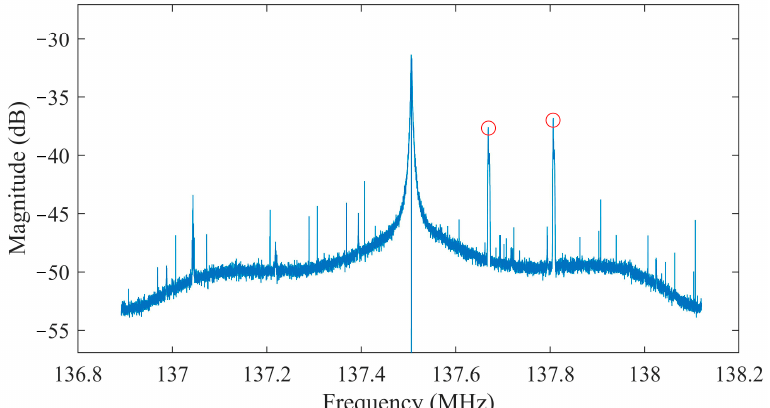
Figure 7. Power spectral density (PSD) analysis representation for the transmitted downlinks of Orbcomm FM 113 satellite.